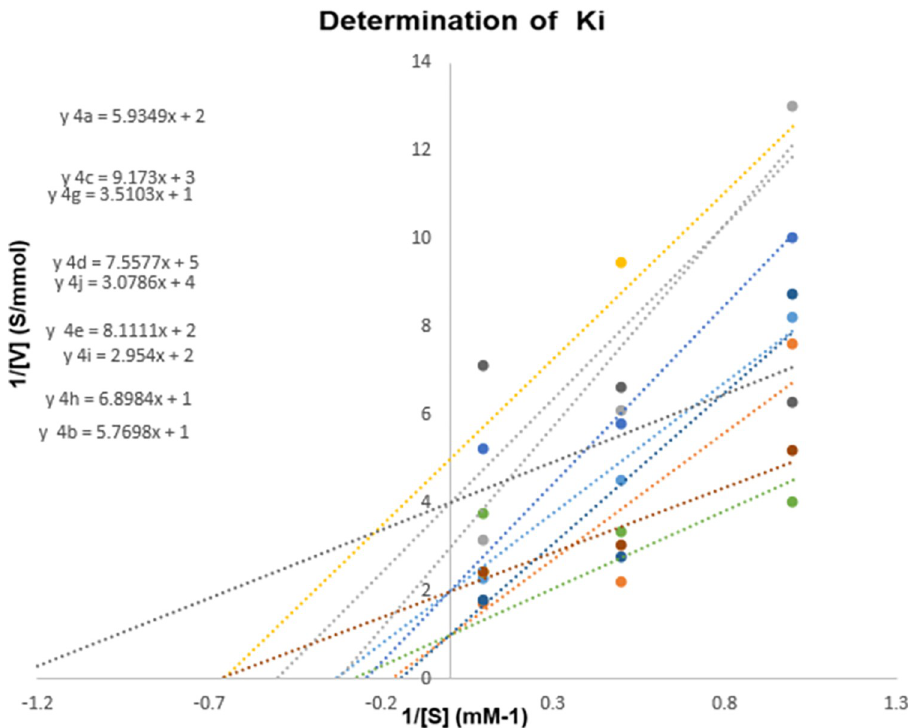
Fig 8. Determination of inhibition type and kinetic parameter.